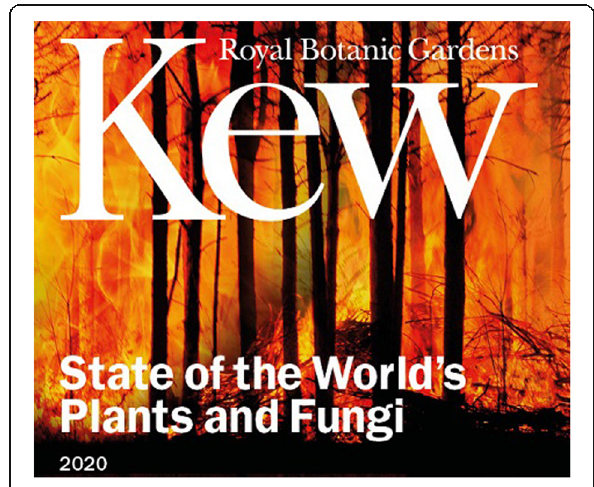
Fig. 8 State of the World ’ s Plants and Fungi